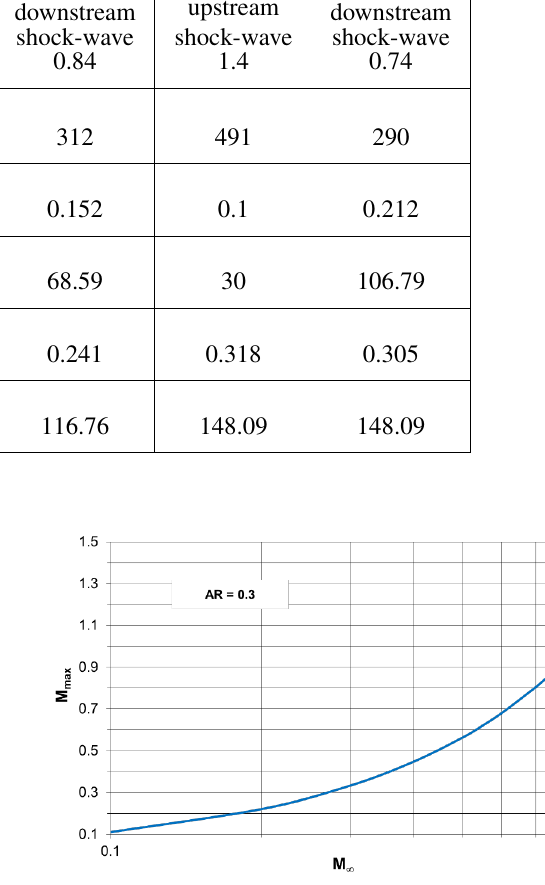
Fig. 8. Graph of the maximum incremental velocity as a function of free stream Mach number M ∞ on an ellipsoid of revolution of the aspect ratio AR = 0 . 3 .